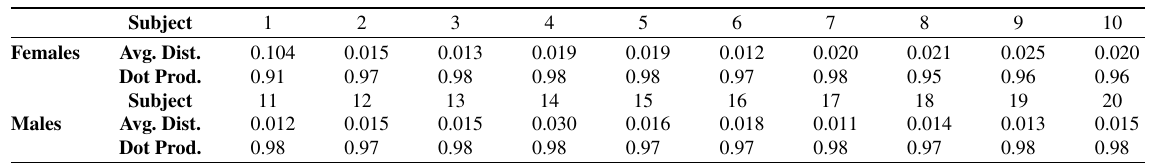
Table 1 of motion studies